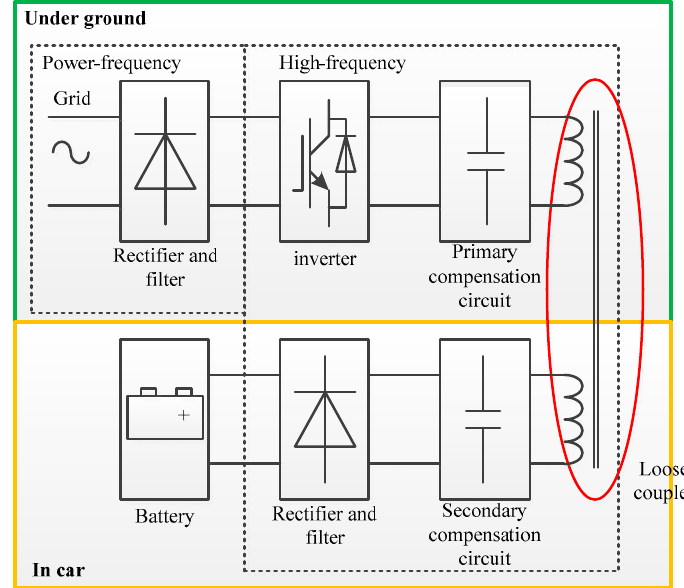
Figure 2. Basic structure of a WPT system.